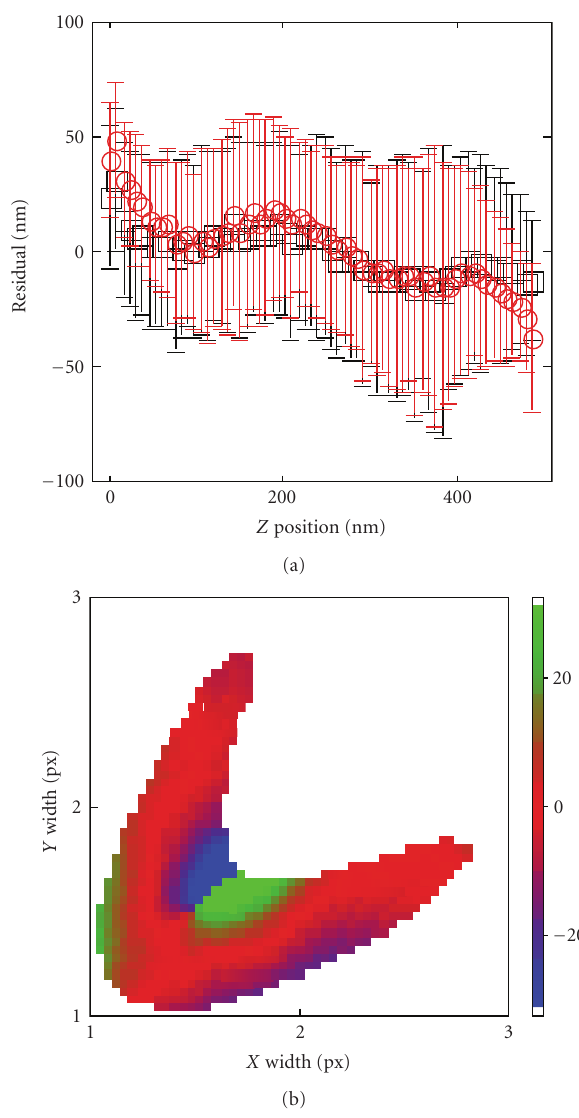
Figure 5: Comparison of the Bayesian and distance estimation methods. (a) Residual errors calculated from a jackknife analysis of the calibration data (see text, Bayesian method: red circles, distance method: black squares). Error bars are standard deviations. (b) z B − z d for di ff erent points in the ( σ x , σ y ) plane. Di ff erences are in nm (color